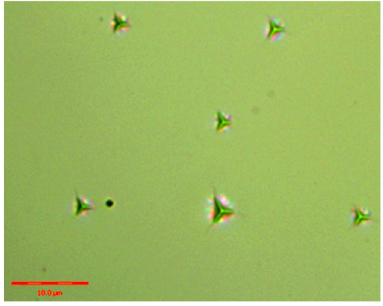
Figure 5. Applied load-displacement curves of Nano-indentation tests.